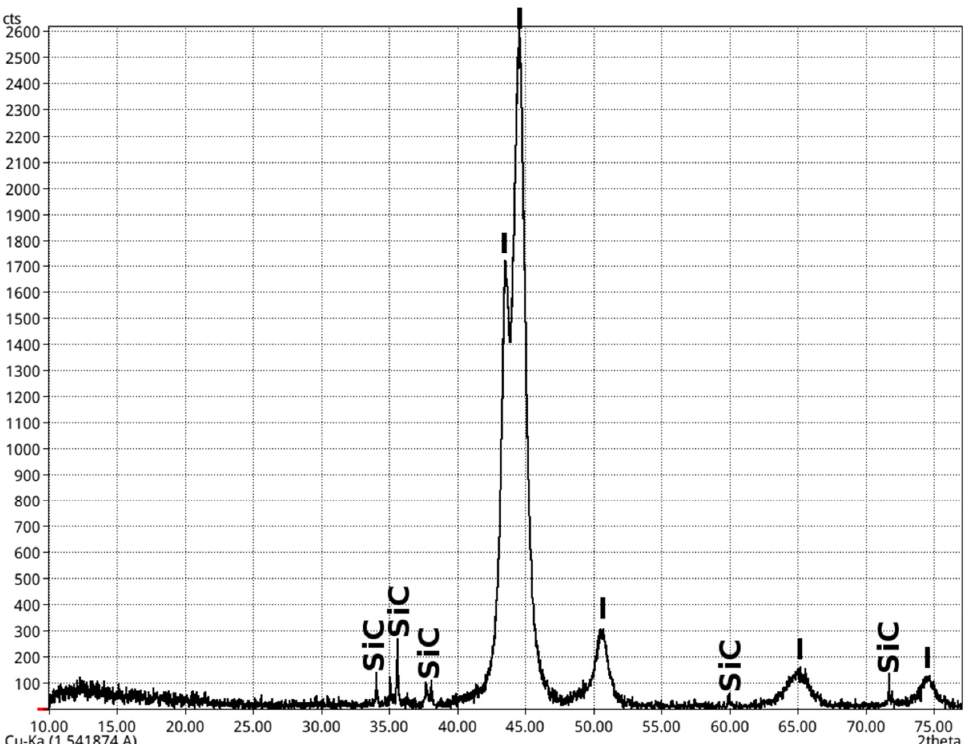
Figure 2. XRD pattern of as-received grinding sludges (I = metallic iron ( α -Fe at 45° and 65° 2 θ ; γ -Fe at 43.5°, 50° and 75° 2 θ ), SiC = silicon carbide).